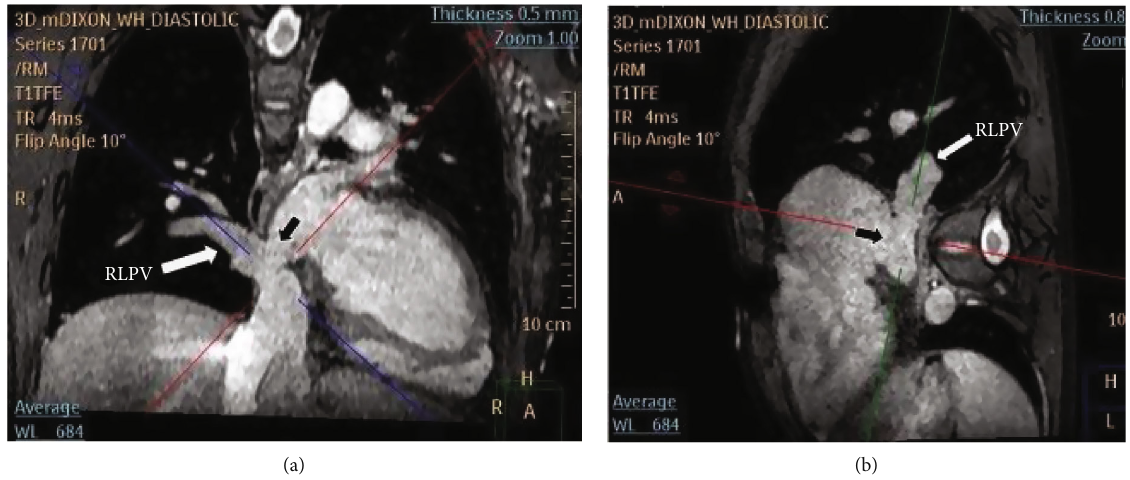
Figure 3: Cardiac magnetic resonance imaging shows a residual sinus venosus defect (black arrow) between the right lower pulmonary vein (RLPV) and inferior vena cava. (a) Coronal view and (b) sagittal view from the left side. Anomalous right lower pulmonary vein drainage can also be observed.